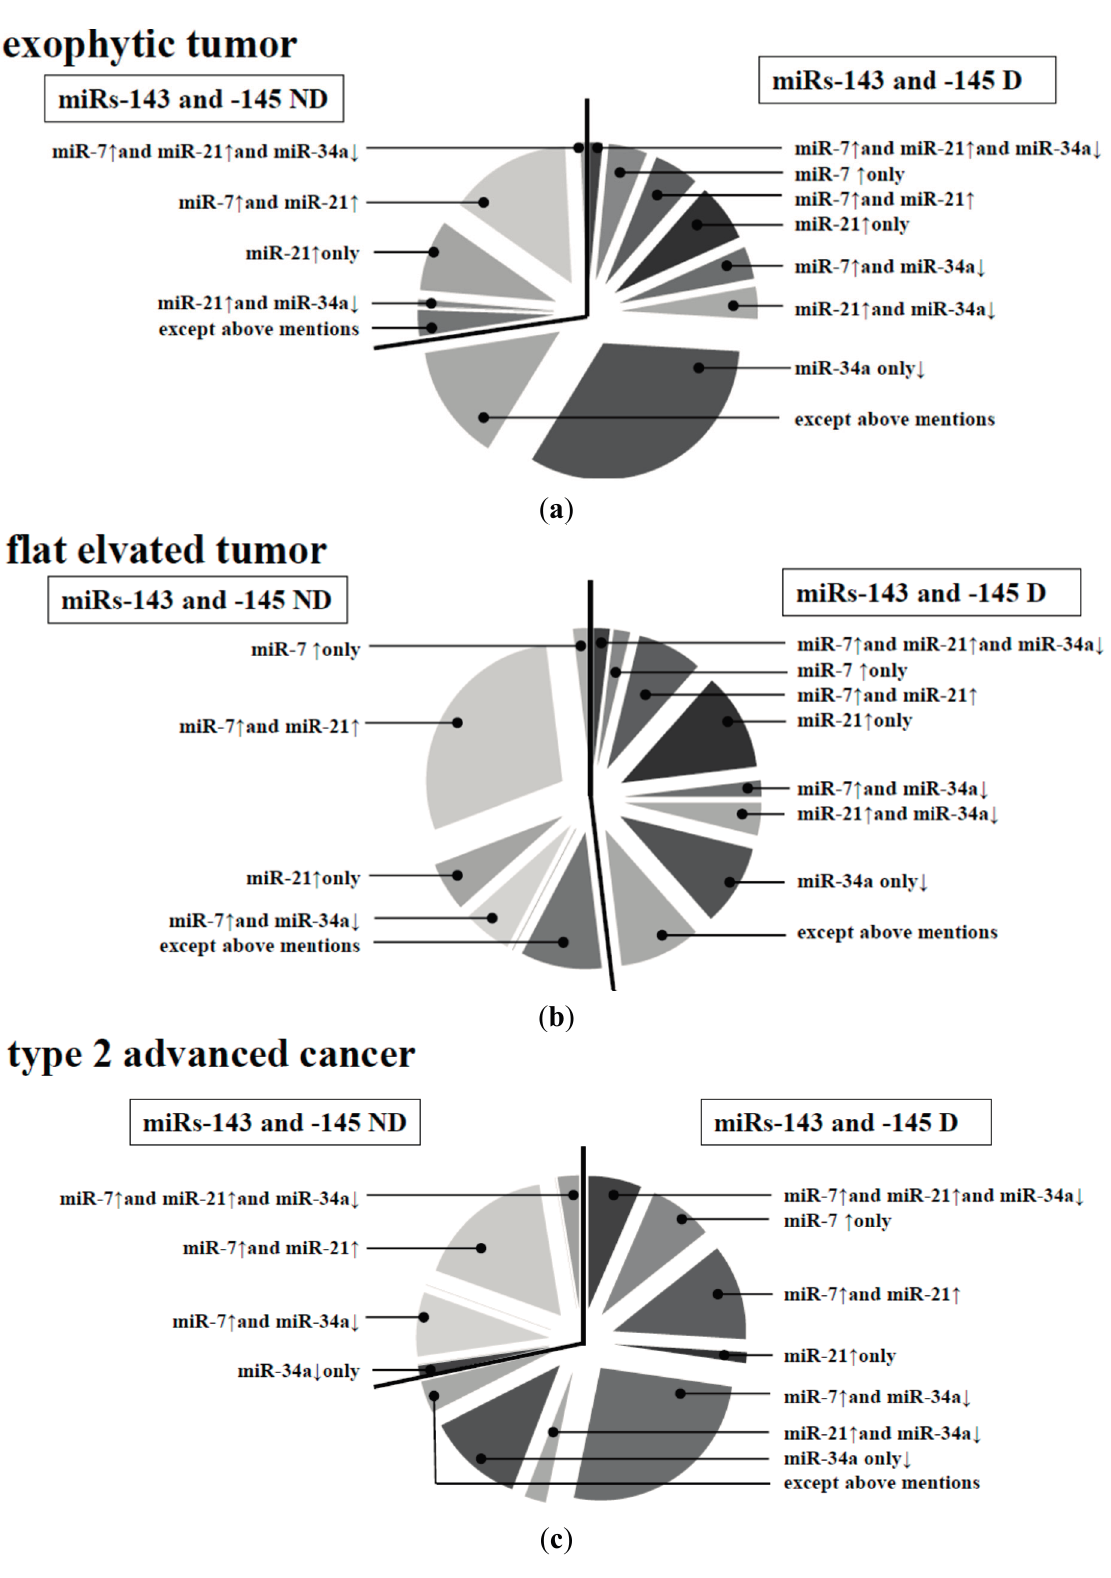
Figure 3. Expression profiles of miRs-7, -34a, and -21 with or without down-regulation of miRs-143 and -145 in human colorectal tumors. ( a ) Exophytic type; ( b ) Flat elevated type; and ( c ) Type 2 advanced cancer. D, down-regulated; ND, not down-regulated. Except above mentions: miR-7 and miR-21 are not up-regulated, and miR-34a is not